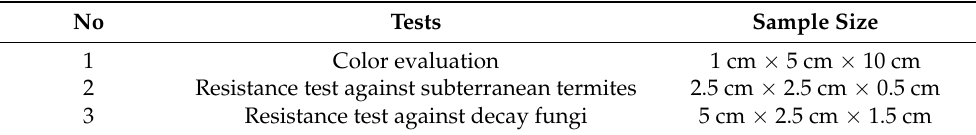
Table 1. The size of the test